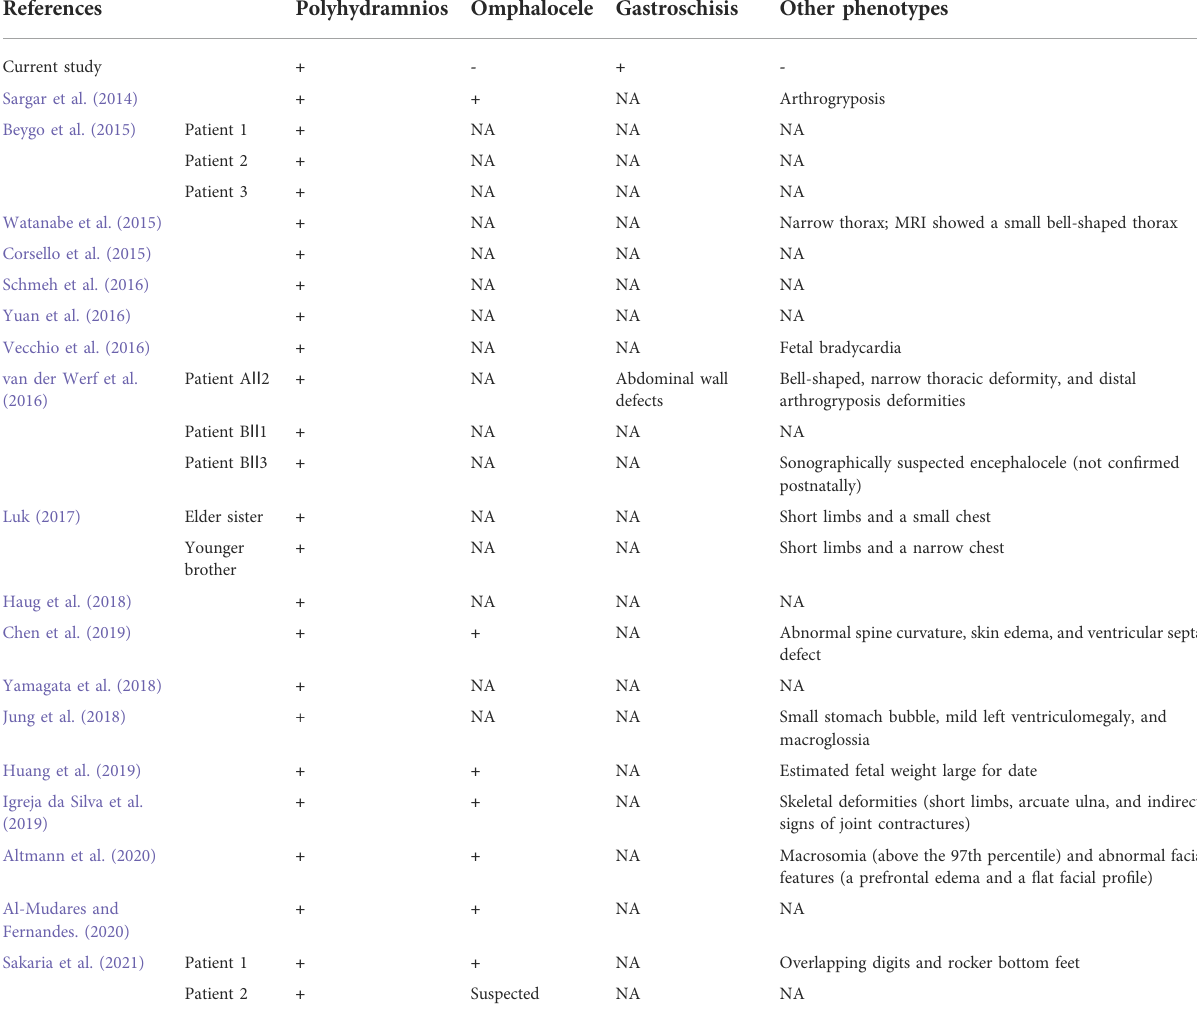
TABLE 2 Summary of prenatal ultrasound fi ndings on previously reported cases of